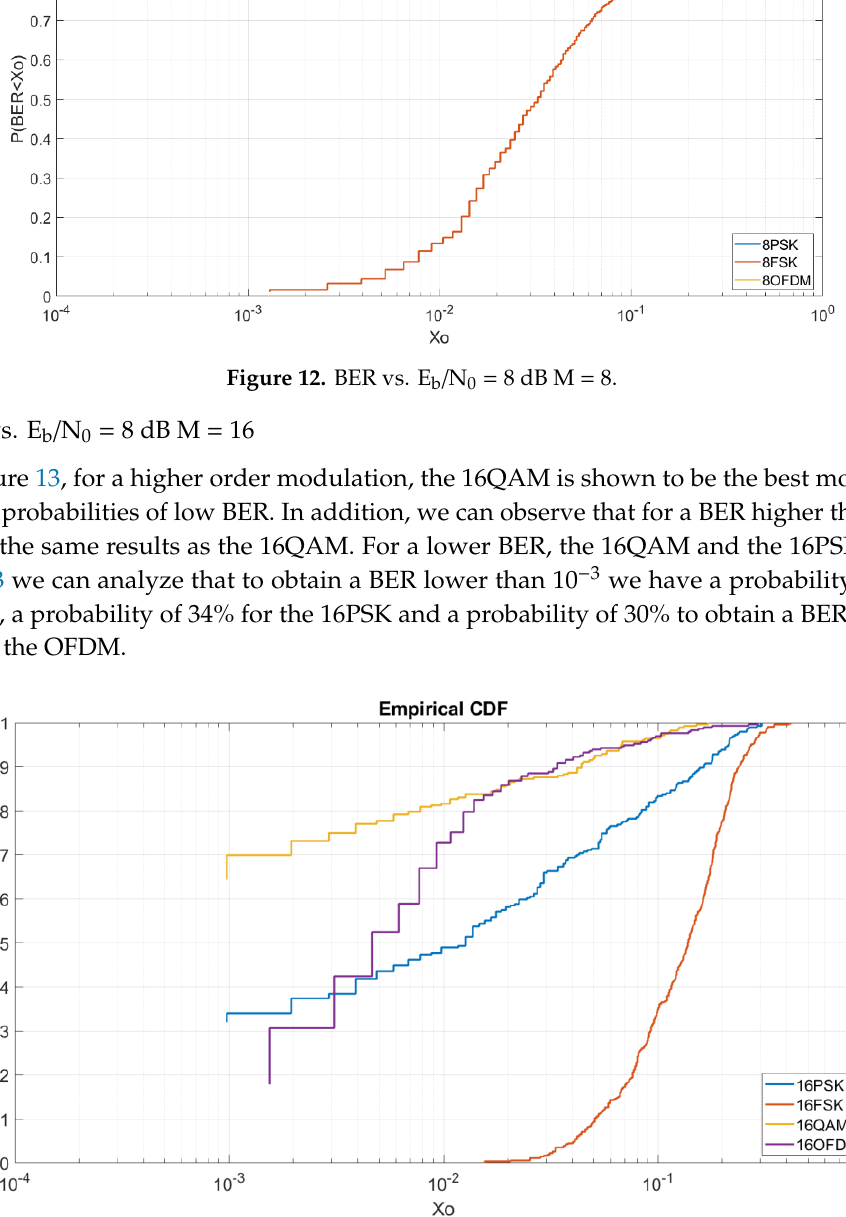
Figure 13. BER vs. E b /N 0 = 8 dB M = 16.